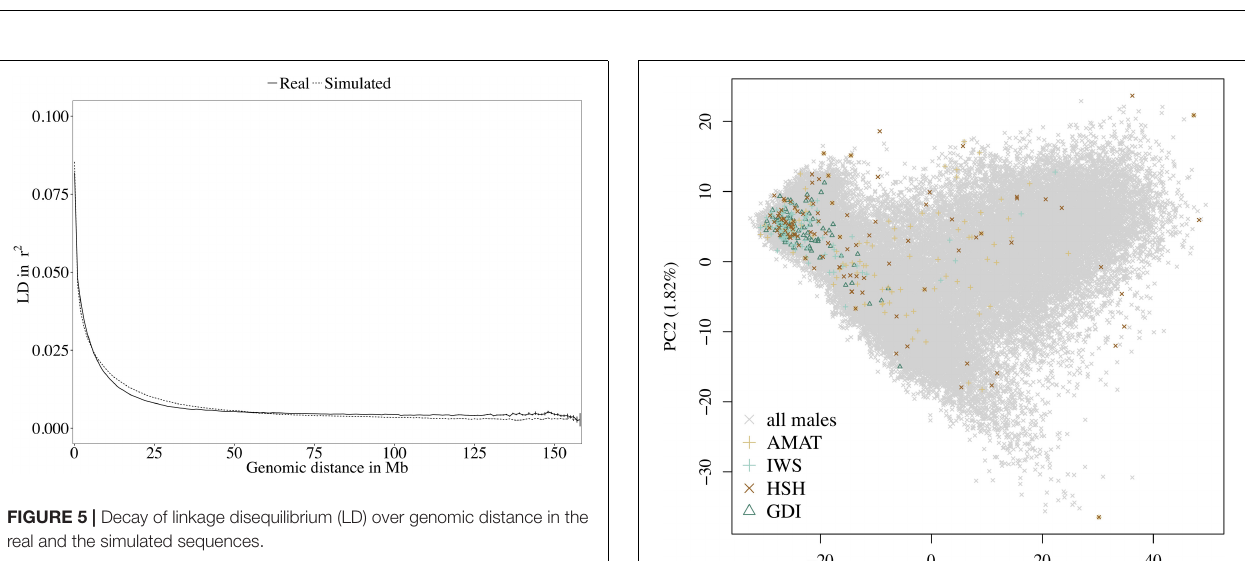
FIGURE 4 | Number of Jersey (JE) animals selected by the Highly Segregating Haplotype selection (HSH), the Inverse Weighted Selection (IWS), and the Genetic Diversity Index (GDI) methods from candidate pools with different proportion of JE animals.